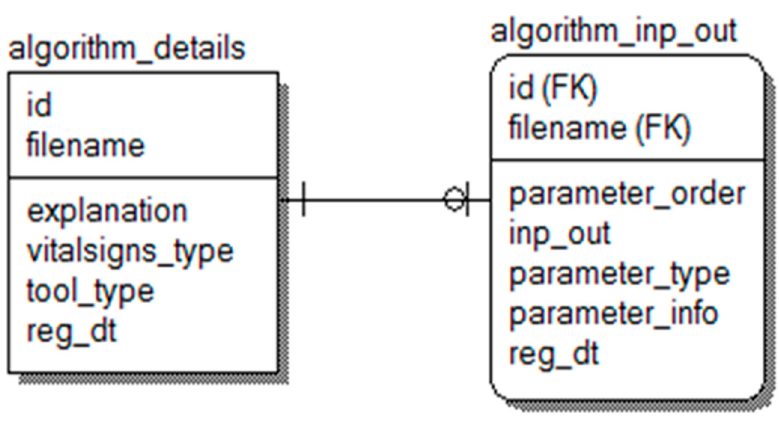
Figure 6. Database modeling for a mining algorithm.